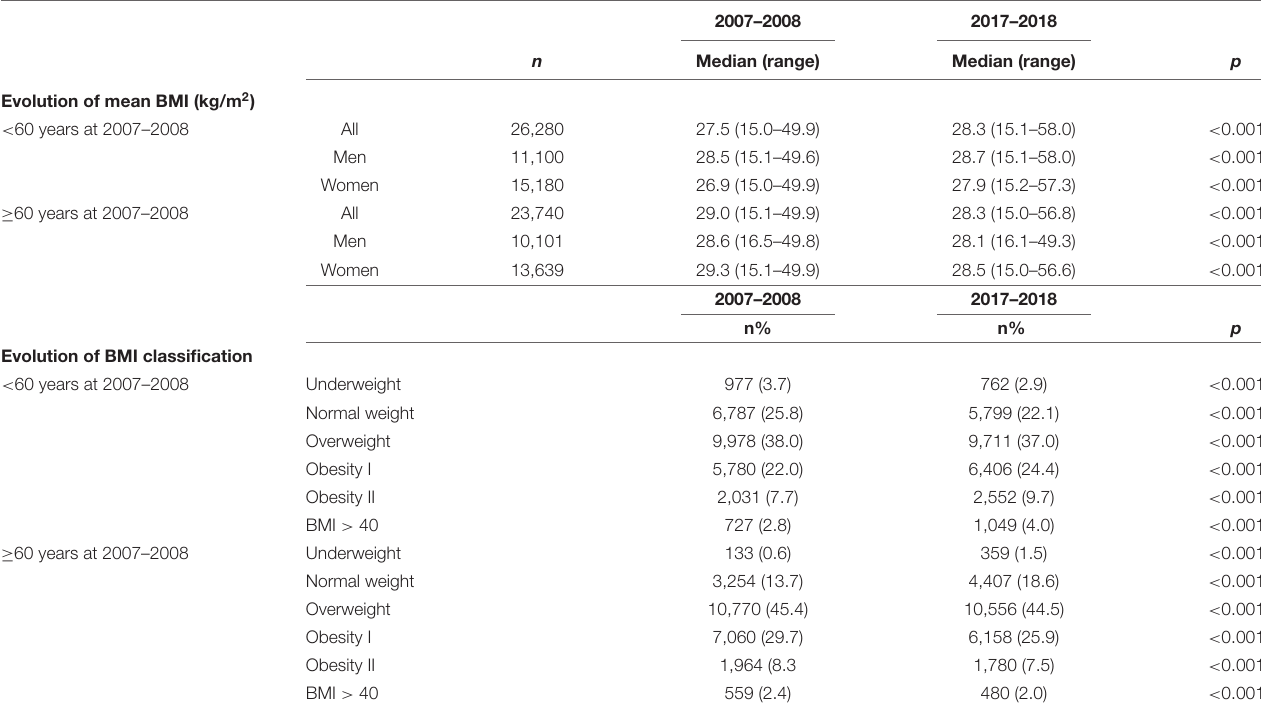
TABLE 3 | Ten-year evolution of the mean BMI and BMI categories in those participants younger and older than 60 years at the first